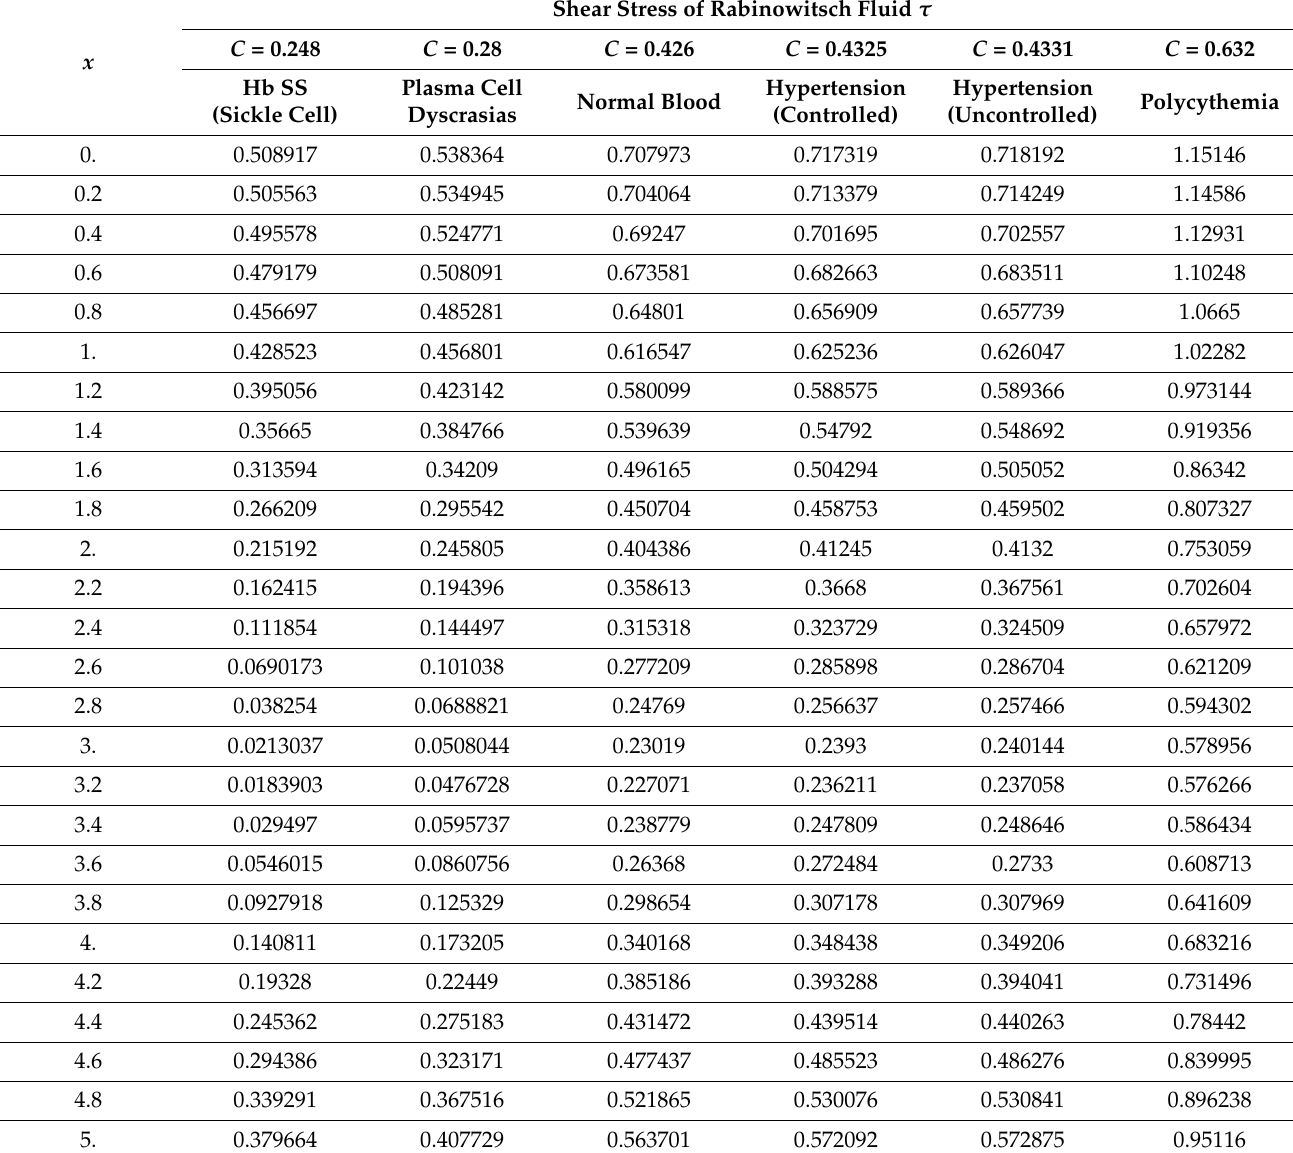
Table 1. Rabinowitsch shear stress through an artery for various values C